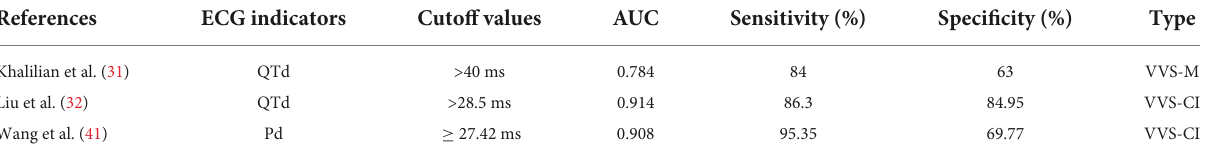
TABLE 2 Predictors of the diagnosis of different subtypes of pediatric VVS.